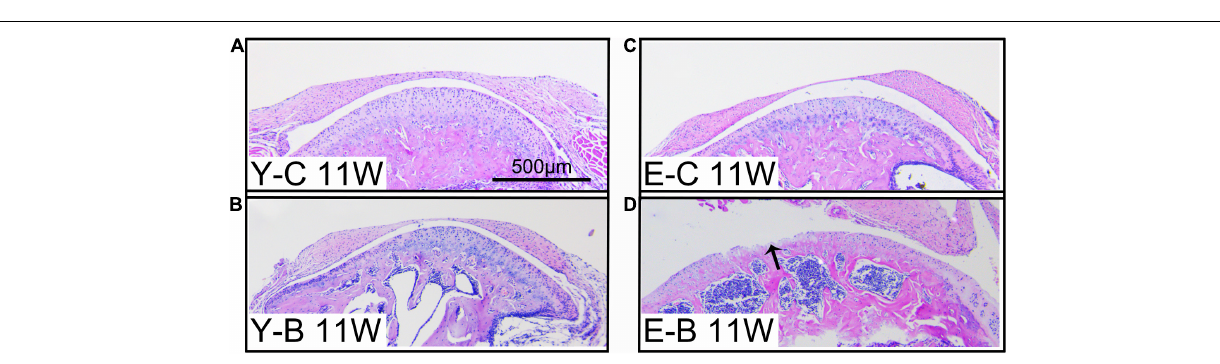
( Figure 3A ). Compared with the age-matched control groups,